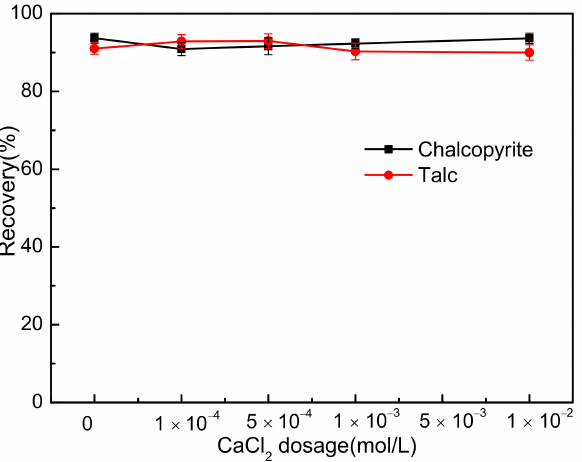
Figure 4. Effect of CaCl 2 dosage on the flotation of chalcopyrite and talc (c(PBX) = 50 mg/L, c (MIBC) = 0.125 mL/L, pH =